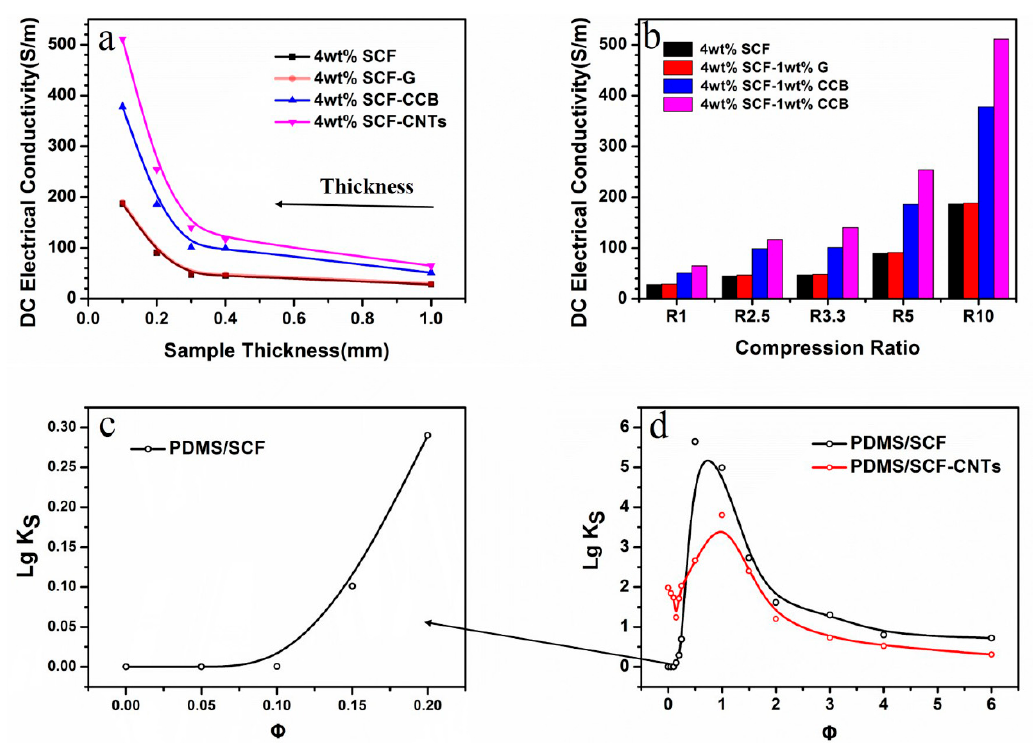
Figure 2. ( a ) Effect of sample thickness on the DC electrical conductivity of PDMS